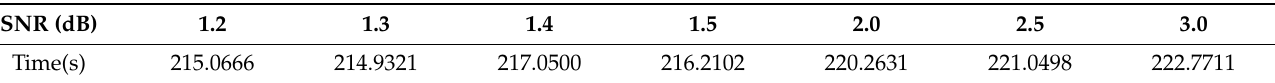
Table 6. Summary of parameters.